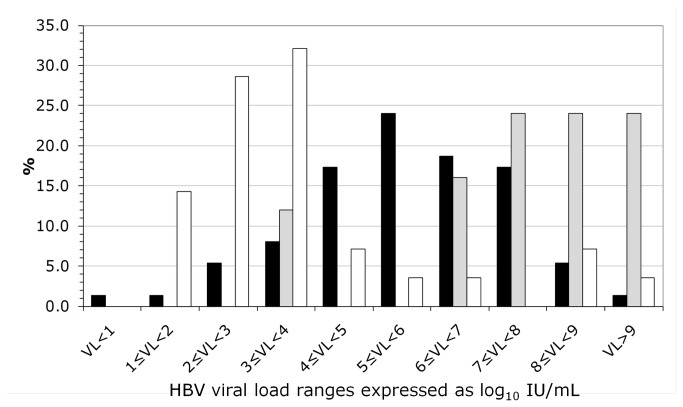
Distribution of HBV-VL (log10 IU/mL) according to disease course.Black bars represent acute cases and gray bars anti-HBc IgM positive chronic cases and open bars anti-HBc IgM negative chronic cases.